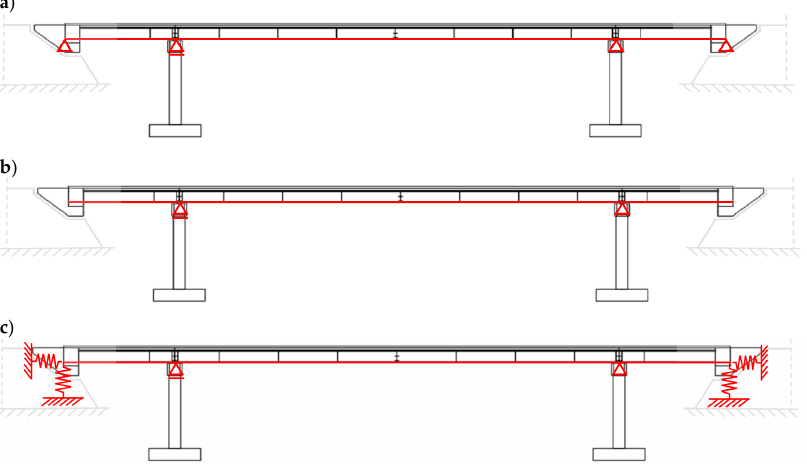
Figure 3. Footbridge structural schematization (red shapes): ( a ) FIX_Ovhg model ( b ) FREE_ Ovhg model, in which overhangs do not interact with the ground ( c ) SPRING_ model with overhangs connected to the ground by springs.